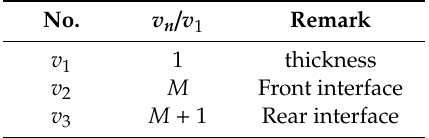
Table 1. Frequency information of each measuring